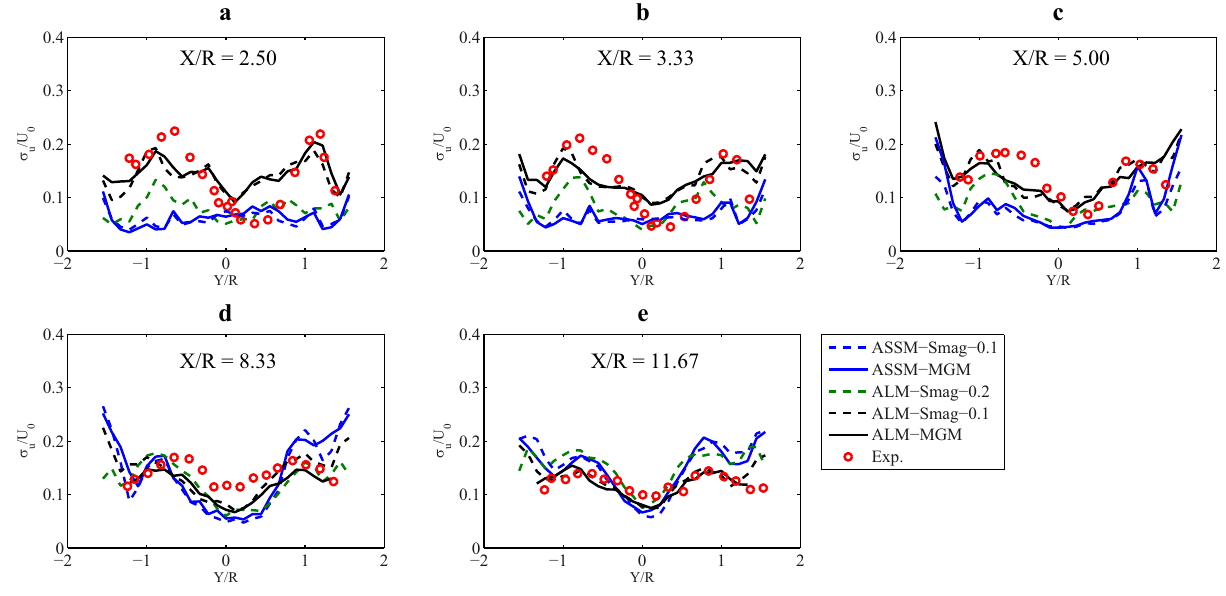
Figure 15. Comparison of spanwise profiles of the normalized mean streamwise turbulence intensity (resolved part), σ ( b ) x/R = 3 . 33 ; ( c ) x/R = 5 . 0 ; ( d ) x/R = 8 . 33 ; ( e ) x/R = 11 . 67 . Water channel measurements (red circles), ALM-MGM (solid black line), ALM-Smagorinsky C (dashed black line), ALM-Smagorinsky C blue line) and ASSM-Smagorinsky C